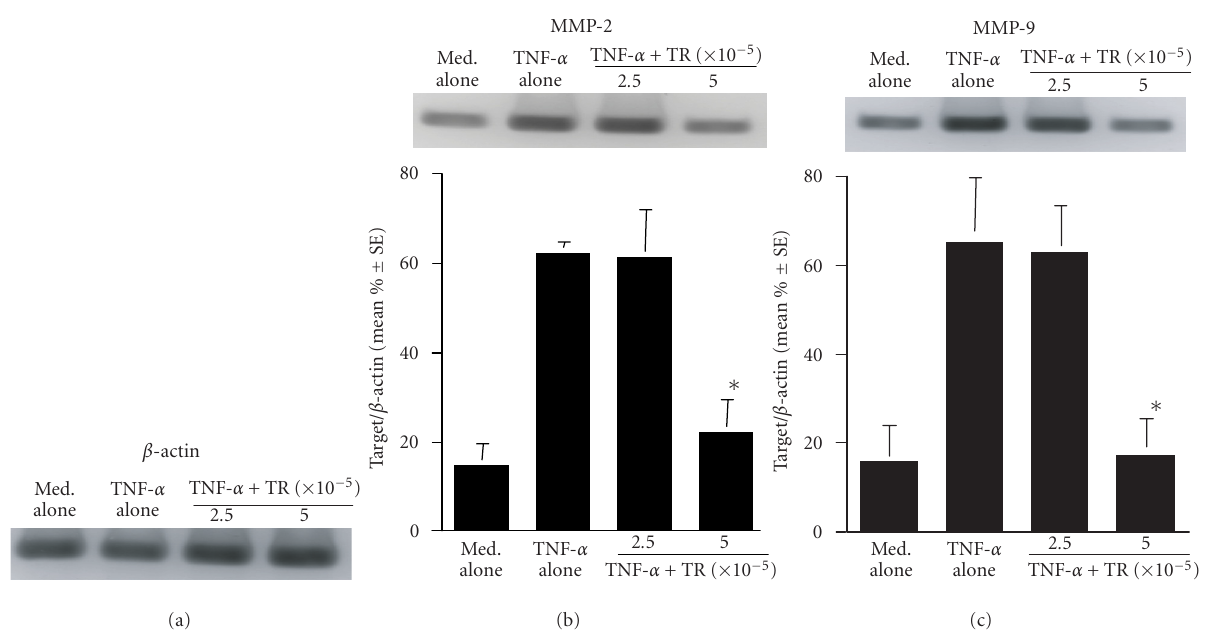
Figure 6. Influence of tranilast (TR) on mRNA expression of (b) MMP-2 and (c) MMP-9 in nasal polyp fibroblasts after TNF- α stimulation. Cells were stimulated with 10 . 0 ng/mL TNF- α in the presence of various concentrations of TR for 12 hours. mRNA expression was examined by RT-PCR. One representative photograph out of five di ff erent subjects is shown. Densitometric analysis of the results of RT-PCR is shown with the intensity of MMP-2 and MMP-9. ∗ means significant ( P < . 05) compared with TNF- α